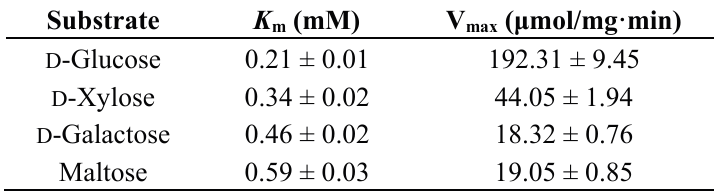
Figure 3. Lineweaver-Burk double reciprocal plots for GlcDH purified from A. globiformis C224. ( A ): D -Glucose as substrate; ( B ): D -Xylose as substrate; ( C ): Maltose as substrate; ( D ) D -Galactose as substrate. Table 4. Kinetic parameters of GlcDH for various